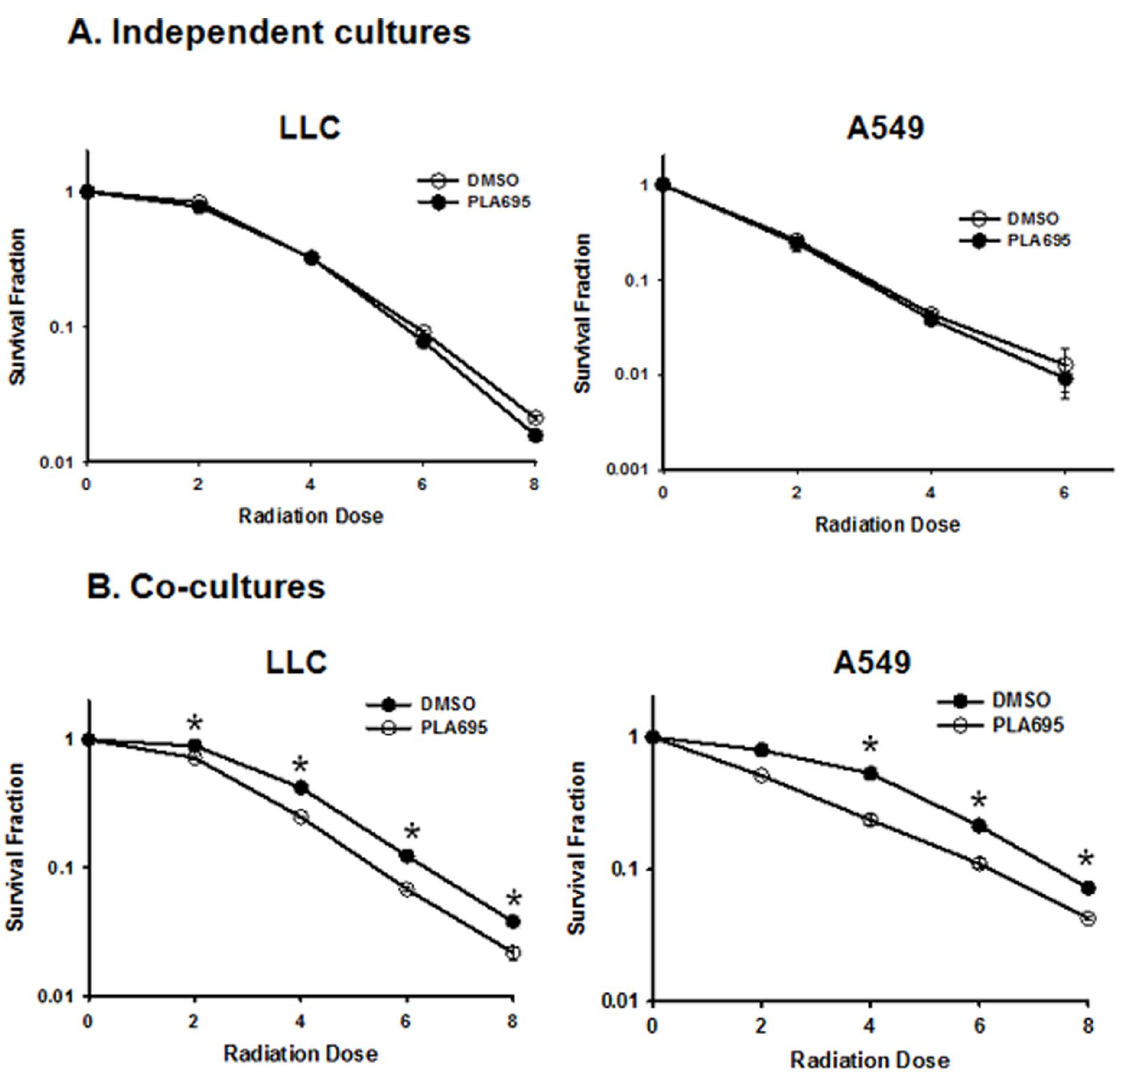
Figure 2. PLA-695 enhances clonogenic cell death in LLC and A549. LLC and A549 cells were grown independently (A) or as co-cultures (B) with bEND3 and HUVEC cells and were treated with DMSO or 300 nM PLA-695 in serum free media for 45 min prior to IR. The cells were then irradiated with 0, 2, 4, 6 and 8 Gy and plated for clonogenic survival assay. After 7–10 days, cells were stained with 1% methylene blue and colonies consisting of . 50 cells were counted by microscopy. Surviving colonies were normalized for plating efficiency. Shown are average survival fractions and SEM.